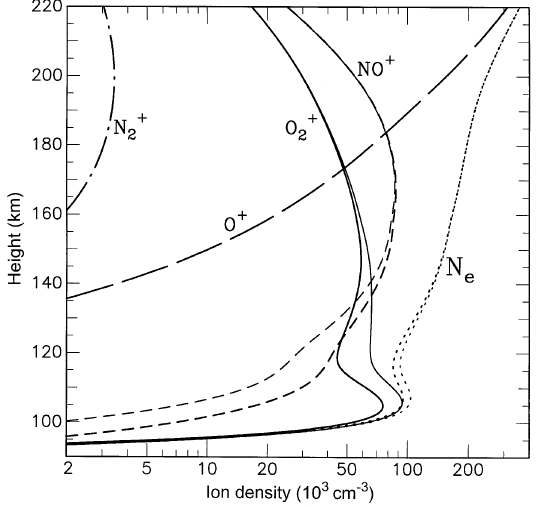
Fig. 4. Ion densities for summer conditions at 40 ° N, with (cid:115) " 60 ° and